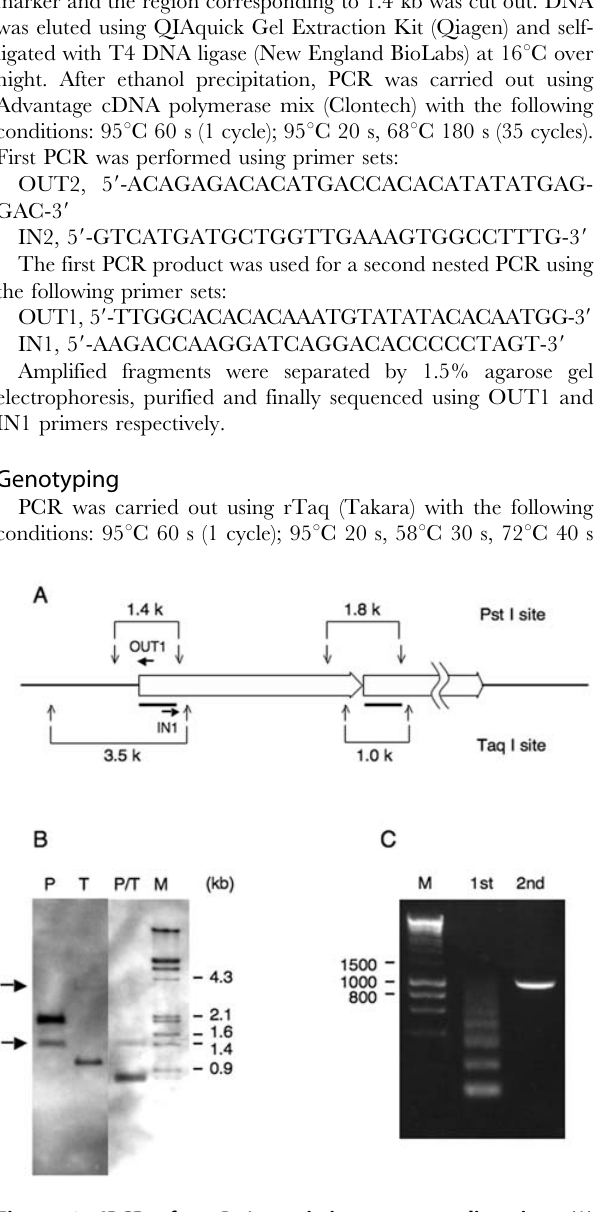
Figure 2. IPCR after PstI restriction enzyme digestion. (A) Restriction enzyme map of PstI and TaqI . PstI and TaqI sites are located approximately 0.7 kb and 2.5 kb up-stream of the transgene, respectively. The bold lines indicate location of the 0.7 kb probe. Primers (OUT1 and IN1) were used for the 2nd IPCR. (B) Southern blot analysis. In addition to the expected size, an additional band (indicated by arrows) was detected by PstI (1.4 kb) and TaqI (3.5 kb) digestion. (C) PstI digested DNA fragment (1.4 kb) was eluted from the gel, purified and IPCR was carried out. The expected size (1 kb) of the 2nd PCR product was obtained.